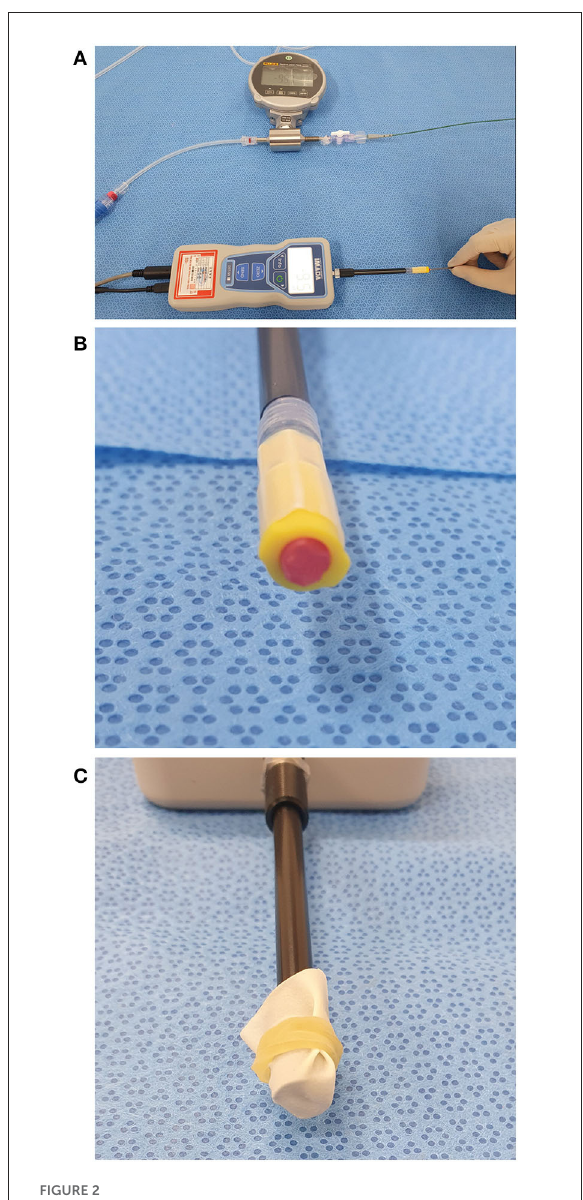
FIGURE2 In vitro measurement of the catheter tip force. (A) A digital force gauge (ZTA-5N, IMADA Co., Toyohashi, Japan) was used to measure the catheter tip force. (B) The artificial thrombus was loaded into a 8 mm-sized polypropylene tube and attached at the end of a load cell attached to a digital force gauge. (C) A latex membrane was attached at the end of the load cell to simulate hard clots such as white